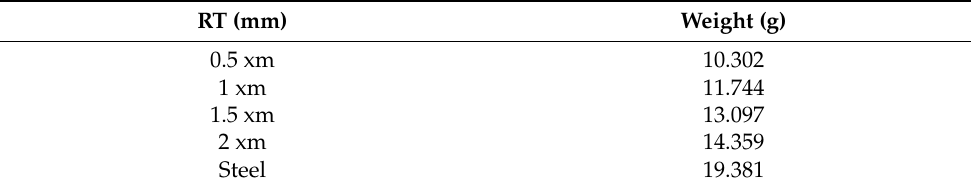
Table 4. Weight status of hybrid and steel gears.